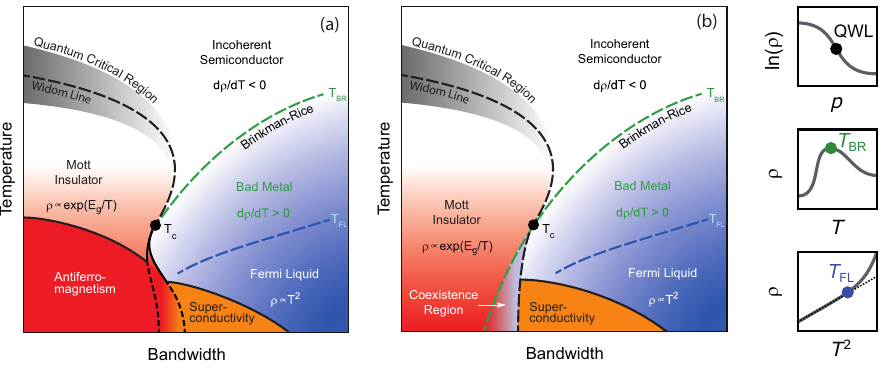
Figure 1. Schematic phase diagram of the quasi-two-dimensional κ -(BEDT-TTF) 2 X salts as prime examples of bandwidth-tuned Mott insulators, where the effect of electronic correlations is reduced with increasing bandwidth. While at high temperatures, an incoherent semiconducting state is found for all systems, the behavior becomes distinct depending on the effect of electronic interactions. For strongly correlated compounds, a Mott-insulating behavior sets in when passing the quantum Widom line (QWL) upon cooling. Weakly correlated systems enter a bad metallic transport regime below the Brinkman–Rice temperature T BR , and Fermi-liquid-like ρ ( T ) ∝ T 2 behavior occurs below T FL . At the verge of metal and insulator, a small region of superconductivity is found typically below 5 to 10 K, but quickly suppressed. The right panels indicate the resistivity signatures of the crossovers in DC transport. The steepest slope of ln { ρ ( T ) } indicates the crossing of the quantum Widom line upon a pressure sweep. T BR indicates the crossover from an insulating (d ρ /d T < 0) to a metallic (d ρ /d T > 0) temperature dependence [26–28]. ( a ) In most cases, Mott insulators order antiferromagnetically, such as κ -(BEDT-TTF) 2 Cu[N(CN) 2 ]Cl; by physical or chemical pressure, the systems undergo a transition from an antiferromagnetic insulator to the superconducting state, such as in κ -(BEDT-TTF) 2 Cu[N(CN) 2 ]Br or κ -(BEDT-TTF) 2 Cu(NCS) 2 , for instance. ( b ) Fully frustrated systems, such as κ -(BEDT-TTF) 2 Cu 2 (CN) 3 , remain paramagnetic down to the lowest temperatures, inferring a quantum spin liquid state. Here, a region of phase coexistence is entered by external pressure or chemical substitution. Eventually, a metallic or even superconducting state